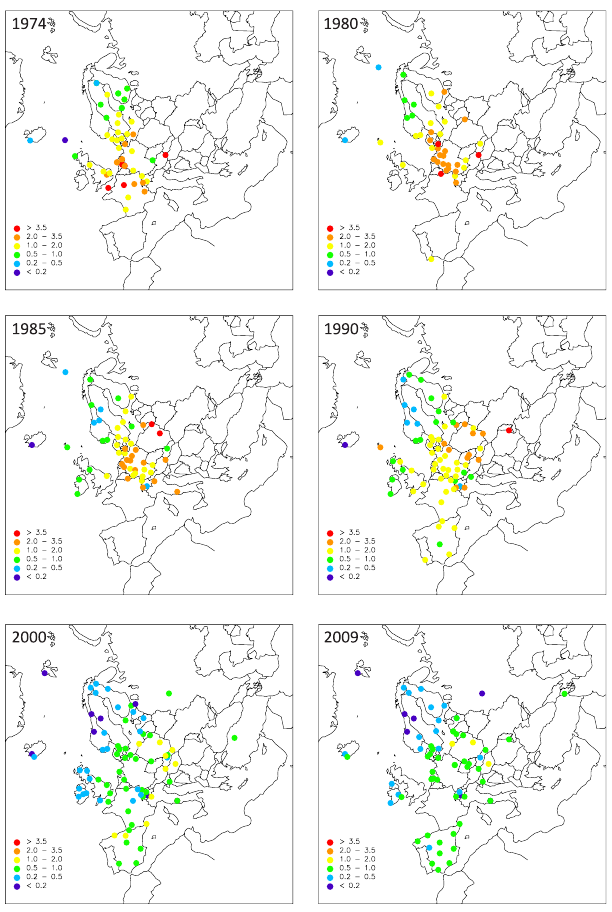
Fig. 3. Annual mean concentrations of SO 2 − to 2009. Unit: µgSm − 3